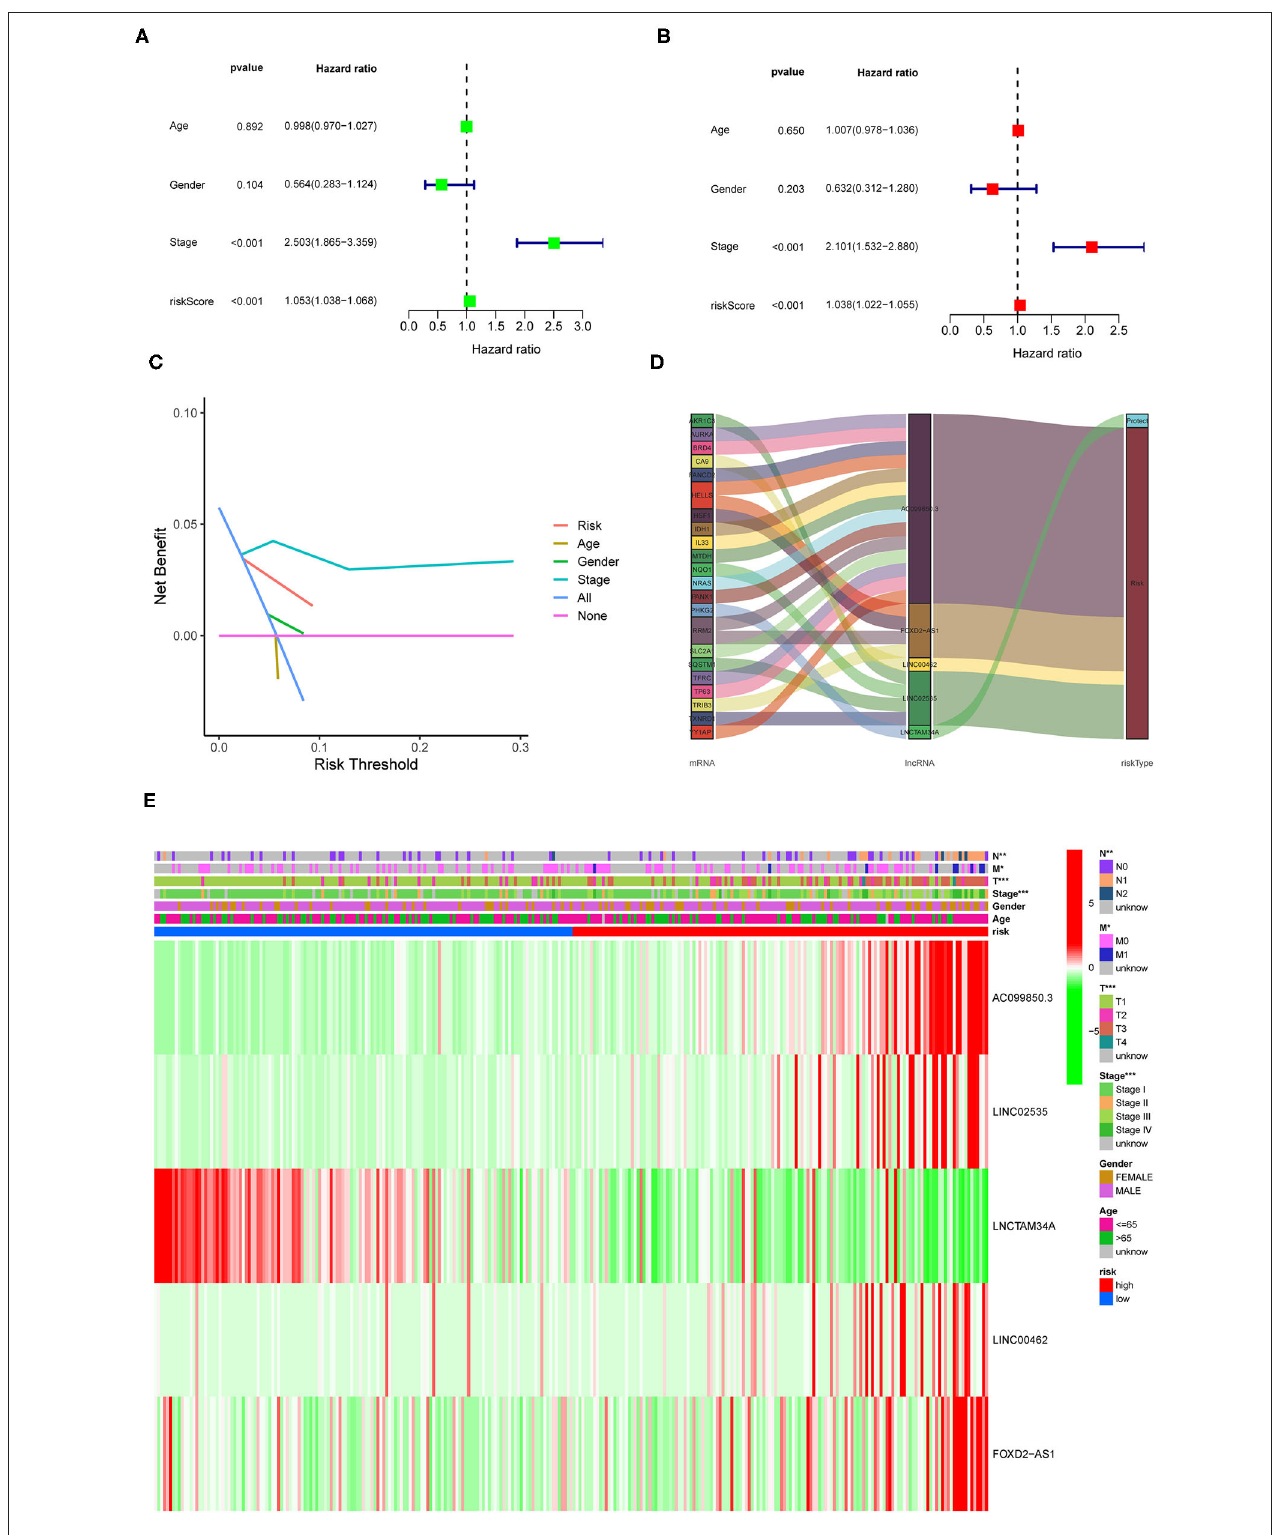
FIGURE 4 | Prognostic value of the identified signature in pRCC. (A,B) Univariate and multivariate COX regression analyses for the expression levels of ferroptosis-related lncRNAs. (C) The decision curve analysis (DCA) results for the risk factors. (D) Sankey diagram showing the relationship between the identified lncRNAs and mRNAs. (E) A heatmap for the identified ferroptosis-related lncRNAs in the prognostic risk model, along with the clinicopathological features.